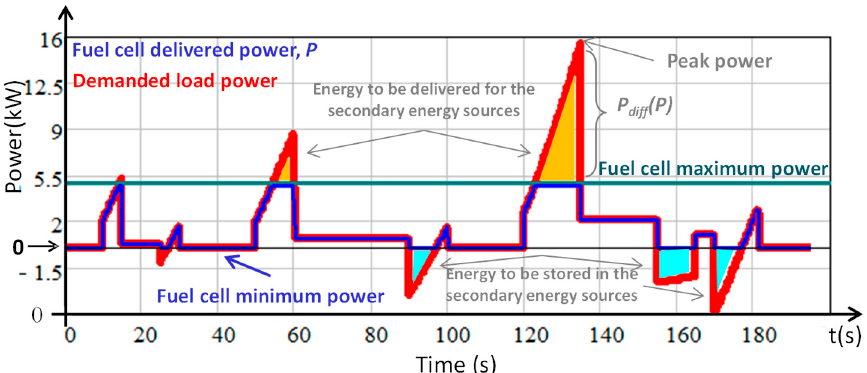
Figure 9. Demanded power by the load along one ECE-15 driving cycle.